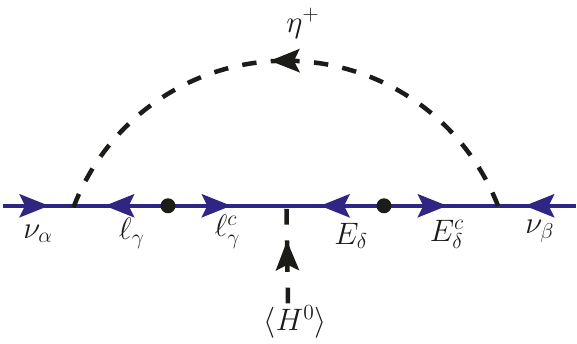
Figure 38 . Neutrino mass generation in the one-loop model with vectorlike leptons. This is the 1 model of table 2 2 O